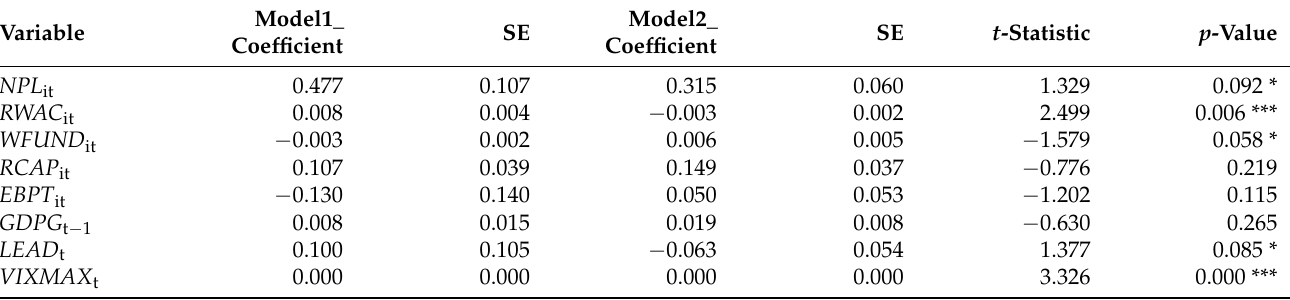
Table A13. Comparison of pre-crisis (1) and crisis (3).